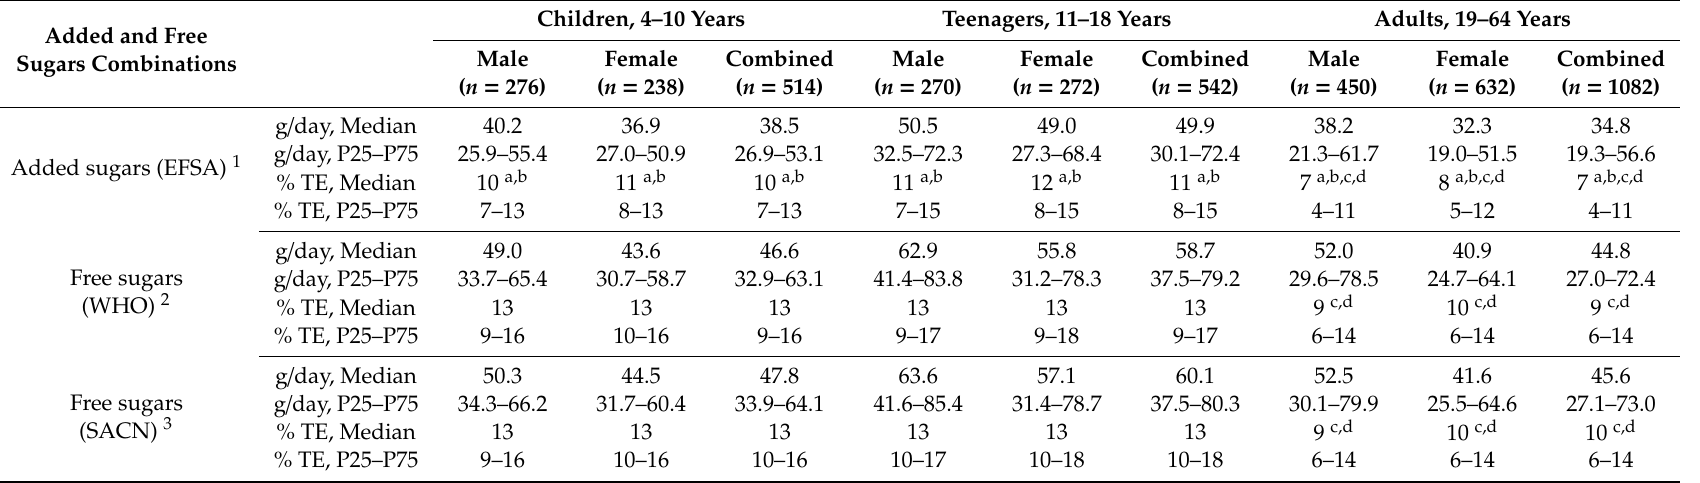
Table 1. Daily intakes of added and free sugars by age and sex (NDNS 2014–2016) (including consumers and